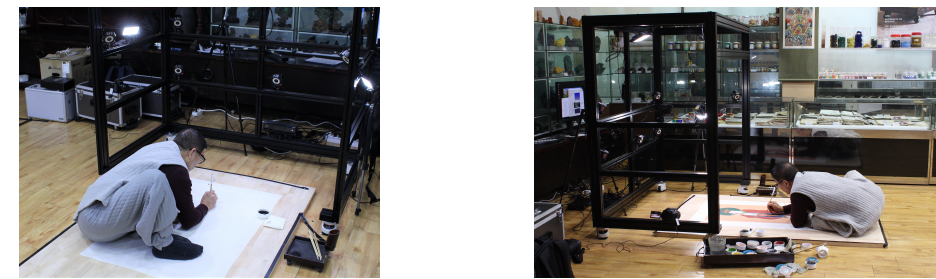
Figure 6. Typical painting work in the sensor frame.The sensors can capture the painting components, such as the painter, brush, and canvas, even outside the sensor frame. Therefore, the painter can work more freely.